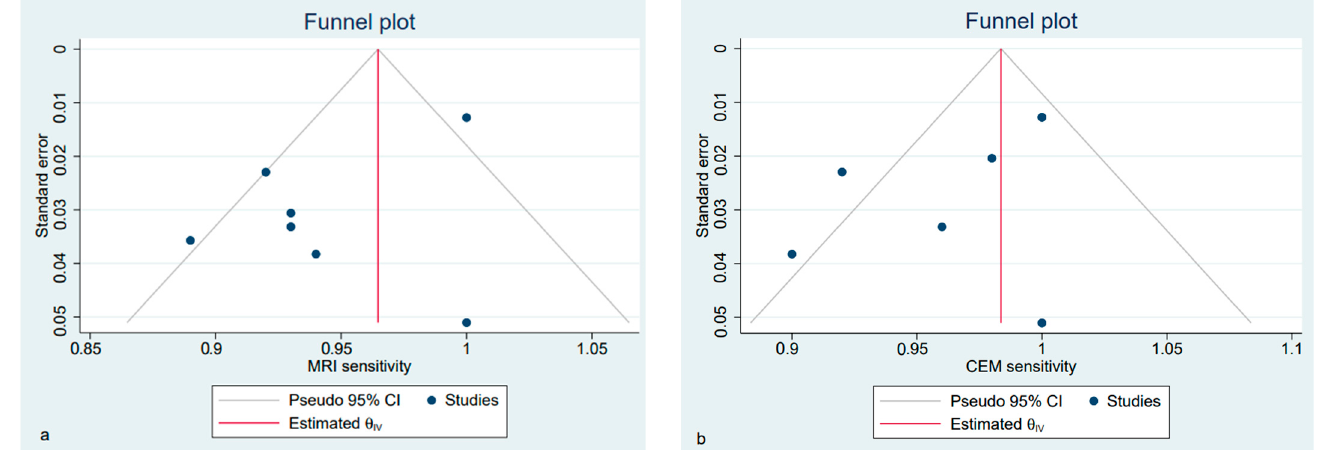
Figure 8. Funnel plot with 95% CIs for publication bias assessment of the pooled sensitivity of CE-MRI ( a ) and CEM ( b ) for the differential diagnosis of suspicious lesions at screening.